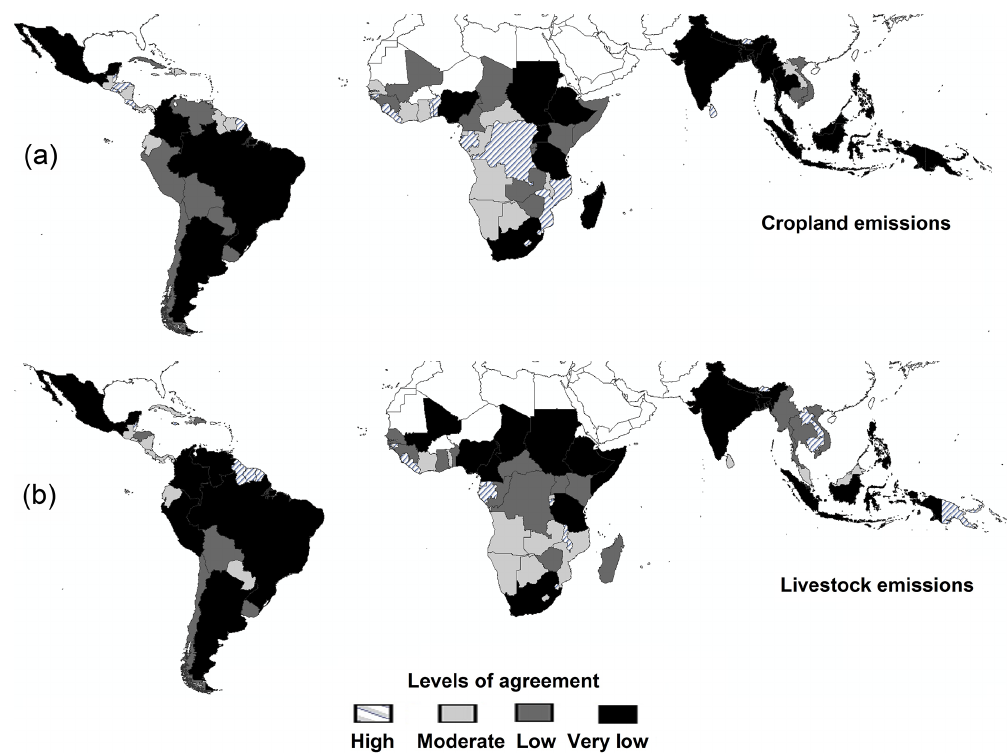
Figure 8. Country-level agreement for (a) cropland and (b) livestock emissions for the FAOSTAT, EDGAR, and Hotspots databases. The categories of agreement are percentiles of the standard deviations which represent a measure of data variability. High agreement corresponds to low data variability ( ≤ 25th percentile), moderate agreement to 25th–50th percentiles, low agreement to 50th–75th percentiles and very low agreement to ≥ 75th, which corresponds to very high data